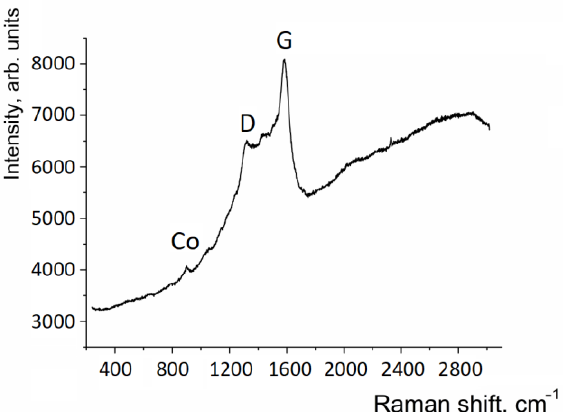
Figure 4. Raman spectrum of the Co-Im/SiO 2 nanocomposite.